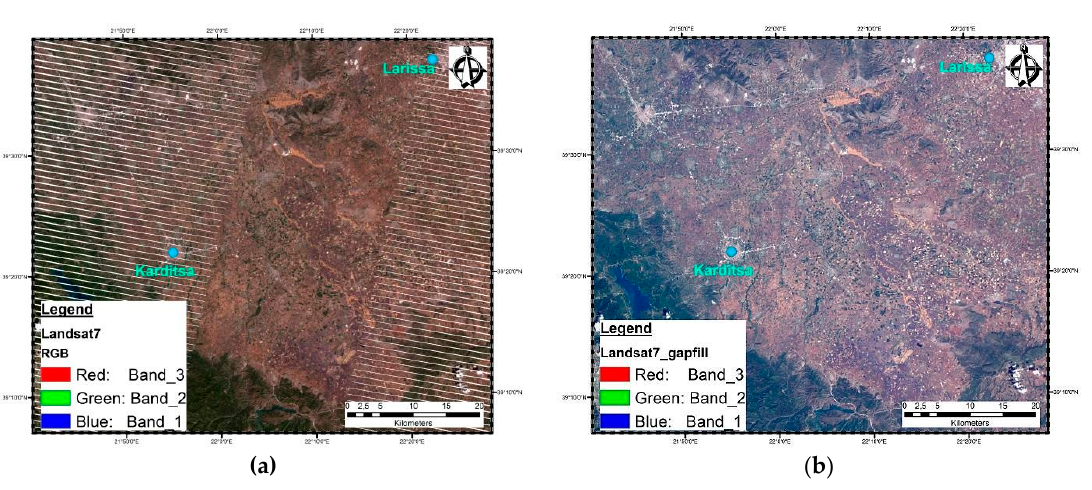
Figure 2. Flow-chart of the implemented methodology.